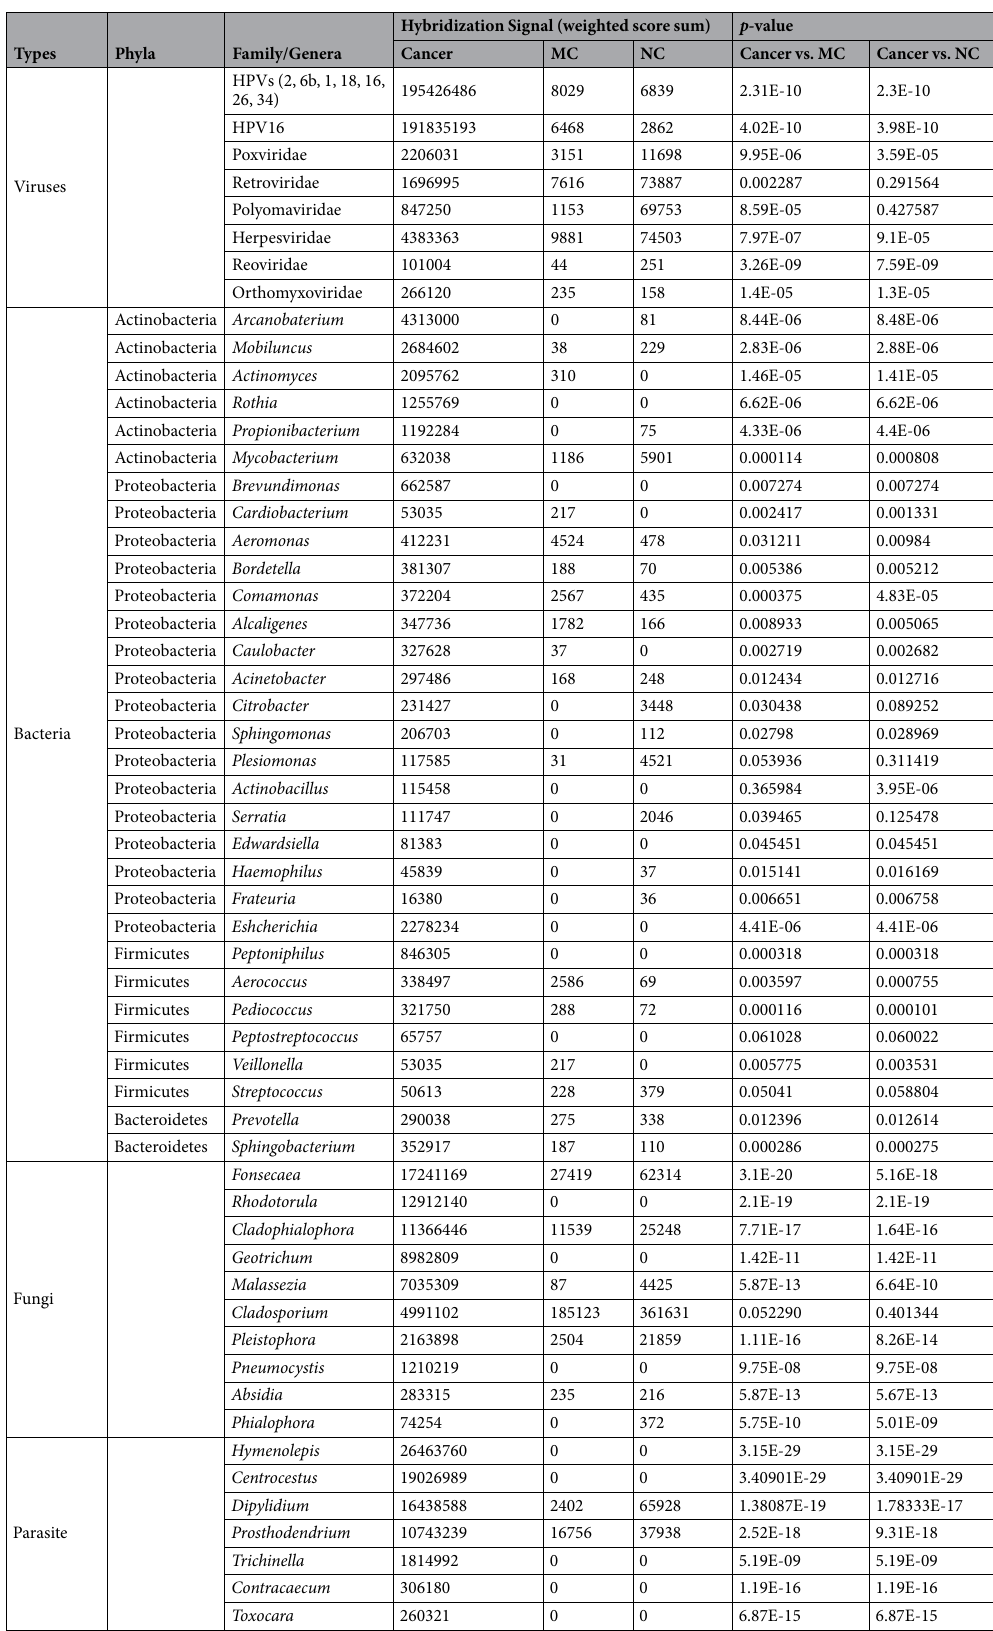
Table 1. Significant detection of the probes of micro-organisms in cancer compared to the matched (MC) and non- matched control (NC) samples. Weighted score sum of the hybridization signals of all the probes of an organism was calculated in cancer and controls, and significance ( p -value < 0.05) was calculated using one sided